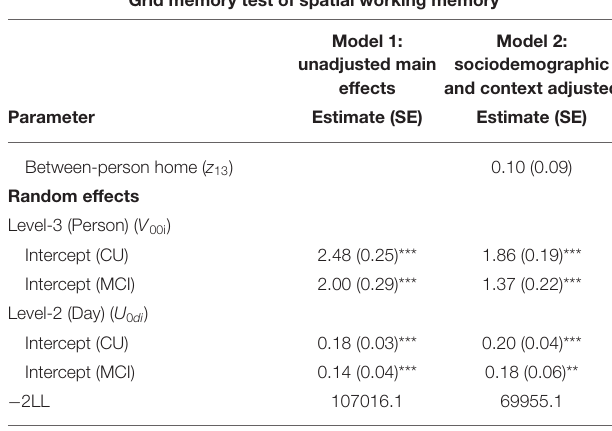
TABLE 4 | Heterogeneous variance models examining cognitive status differences in mean and variability in grid memory